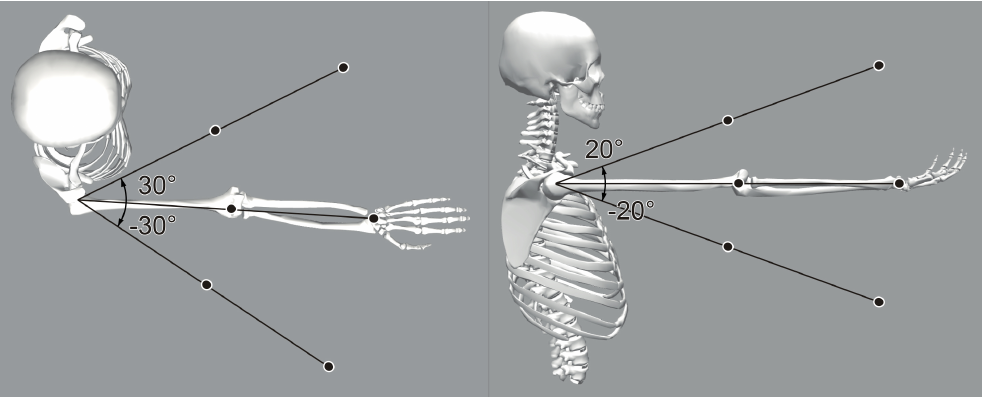
Figure 4. Set of points used for the evaluation of the objective function of the